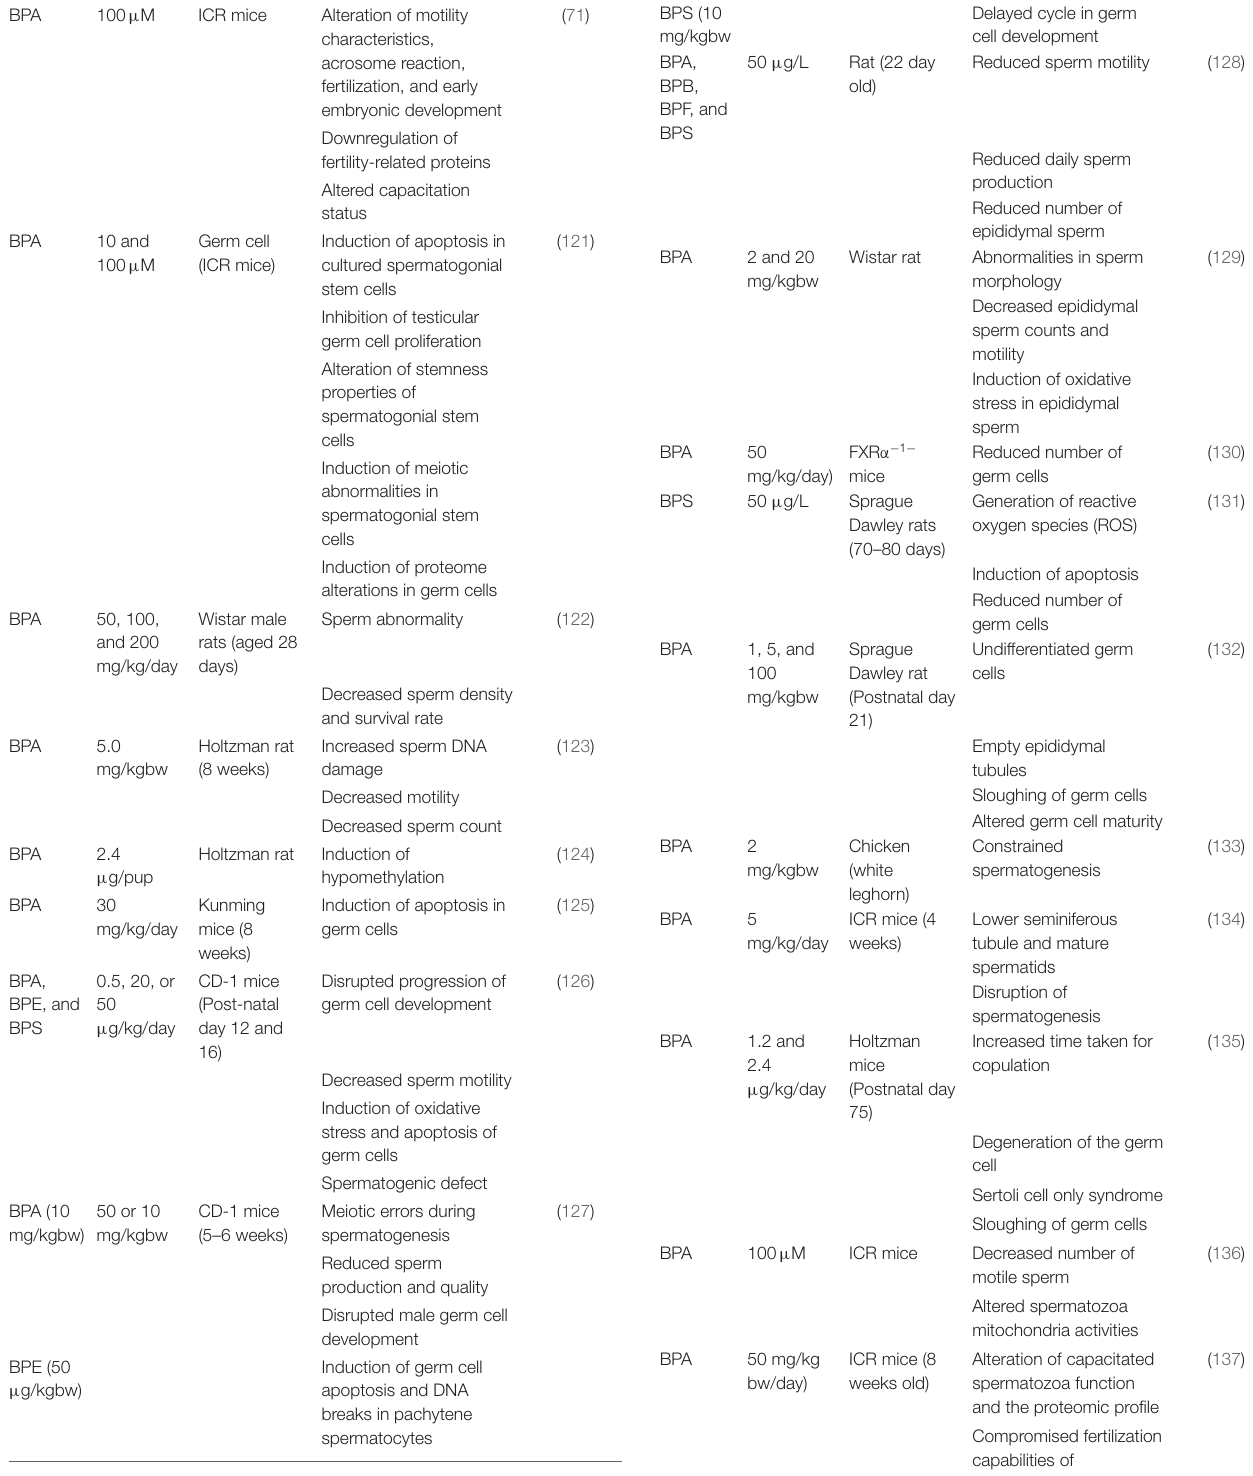
TABLE 3 | Effect of bisphenols on germ